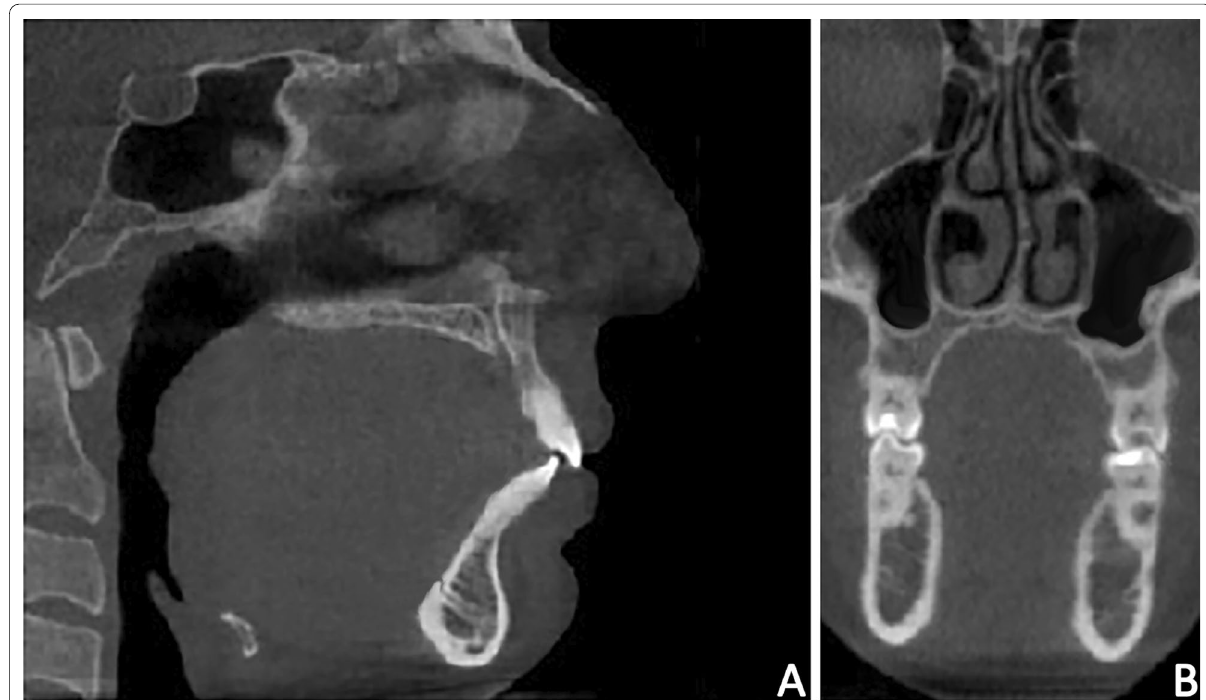
Fig. 2 The new cropped DICOM file generated with the exclusion of the slices in over the borders of V.O.I. A ) Medio-sagittal scan; B ) Coronal scan